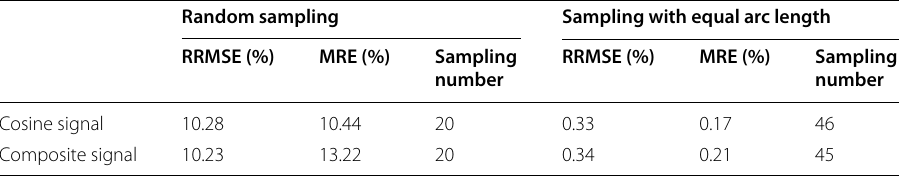
Table 1 Reconstructing error of nonuniform sampling with random and equal arc length